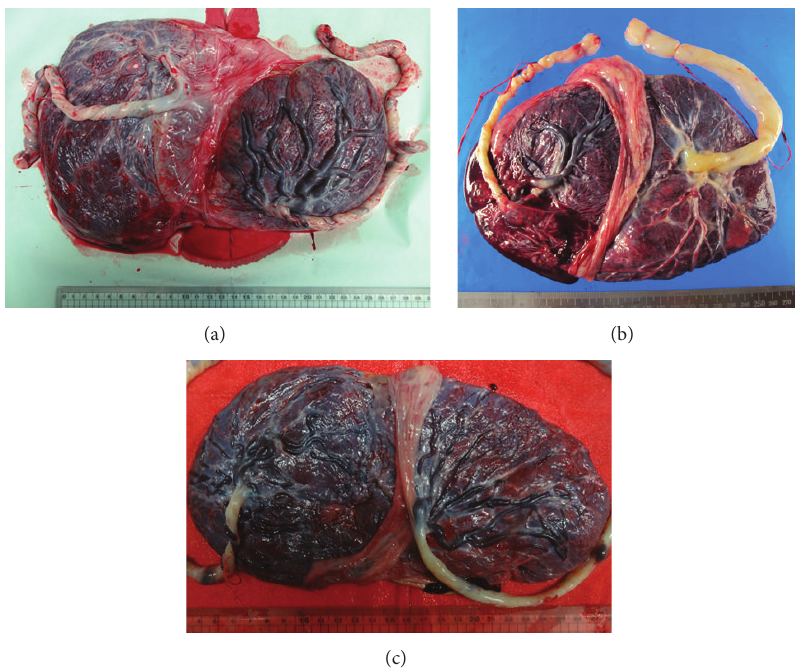
Figure 1: Placentas of 3 cases. (a) Placenta of case 1. (b) Placenta of case 2. (c) Placenta of case 3. (a) There is an obvious difference of placental area between the FGR fetus and the normal fetus. (b, c) There is no marked difference of placental area between the FGR fetus and the normal